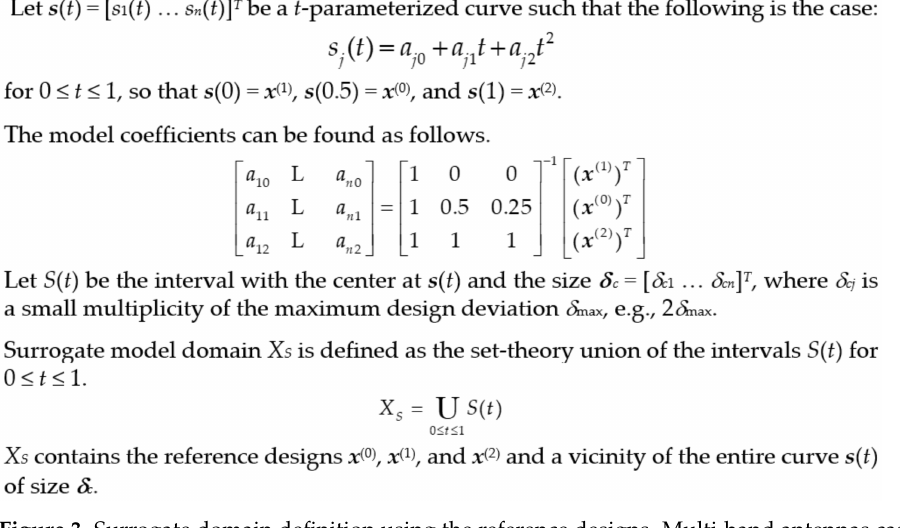
Figure 3. Surrogate domain definition using the reference designs. Multi-band antennas